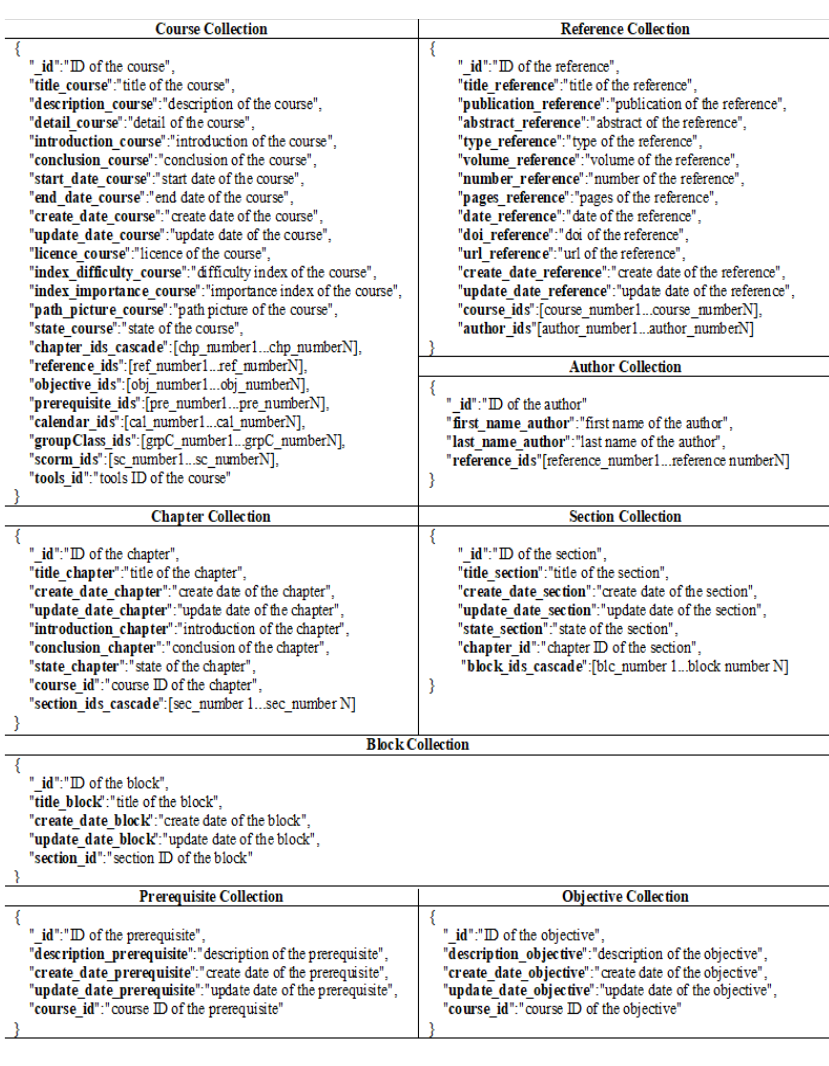
Table 3. Course collections of MongoDB NoSQL database of